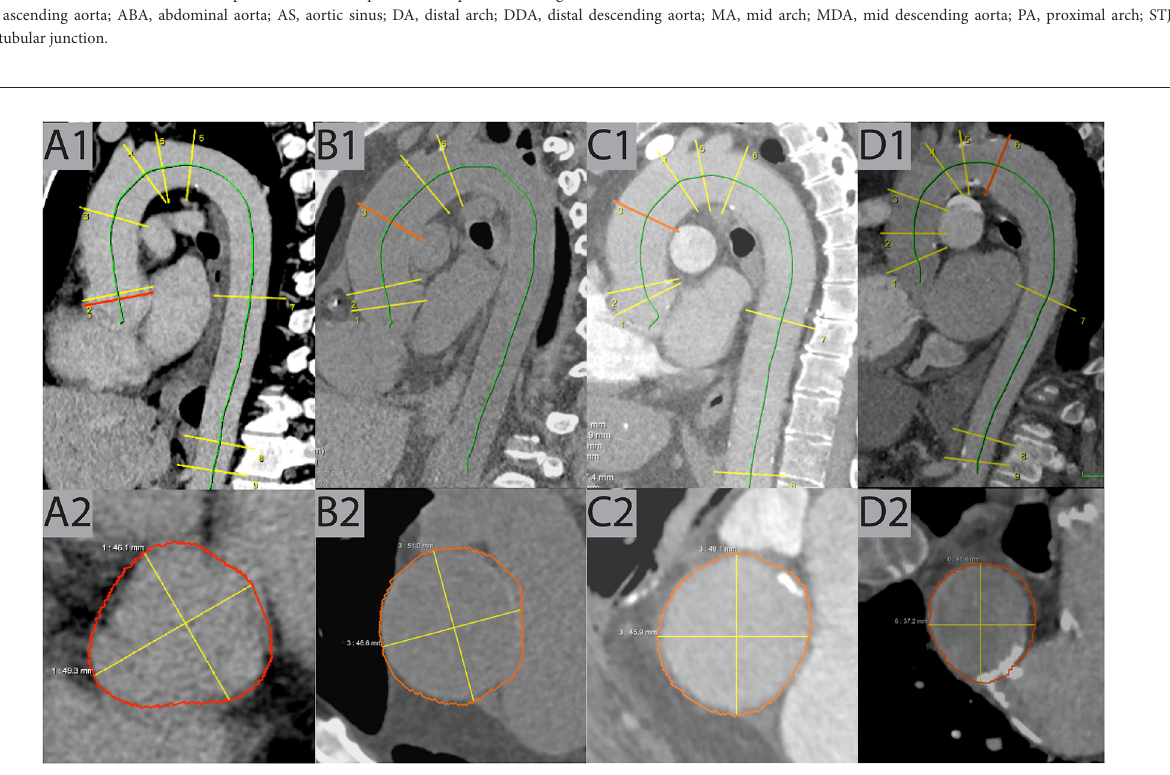
17,691/18,243 (97%) of those exams with different